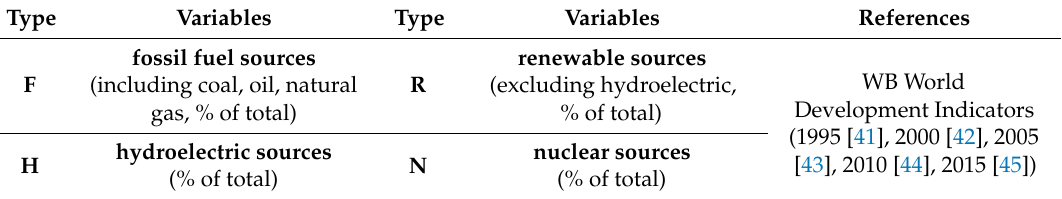
Table 1. The Variable Framework of the ideal type analysis.